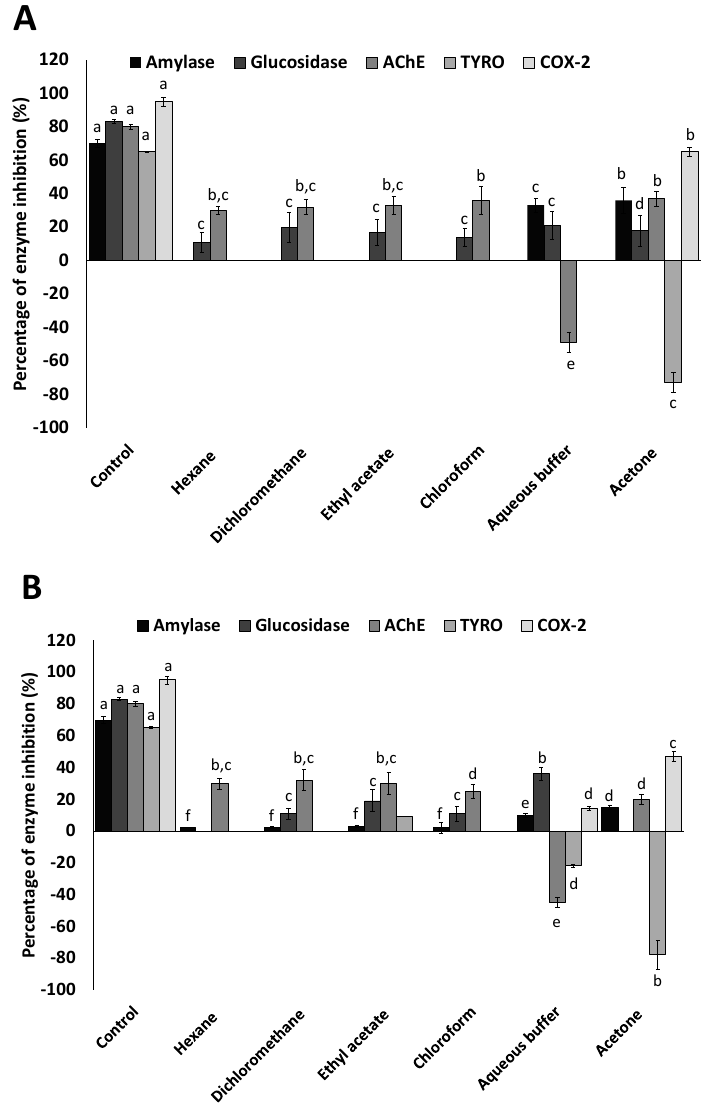
Figure 3. In vitro activity of haloarchaeal extracts on enzymes related to diabetic, neurodegenerative skin pigmentation, and inflammatory diseases. Percentages of inhibition of the enzymes: α -amylase, α -glucosidase, acetylcholinesterase (AChE), tyrosinase (TYRO) and cyclooxygenase 2 (COX-2) by the all extracts obtained in different solvents (hexane, dichloromethane, ethyl acetate, chloroform, aqueous buffer and acetone) from H. hispanica HM1 ( A ) and H. salinarum HM2 ( B ) strains are represented. A known inhibitor for each enzyme was included as control. For each assay, the data were submitted to one-way variance analysis (ANOVA). Bars are followed by different superscript letters (a–f), which denote groups with significant differences according to the Duncan’s Multiple Range Test ( p < 0.05).